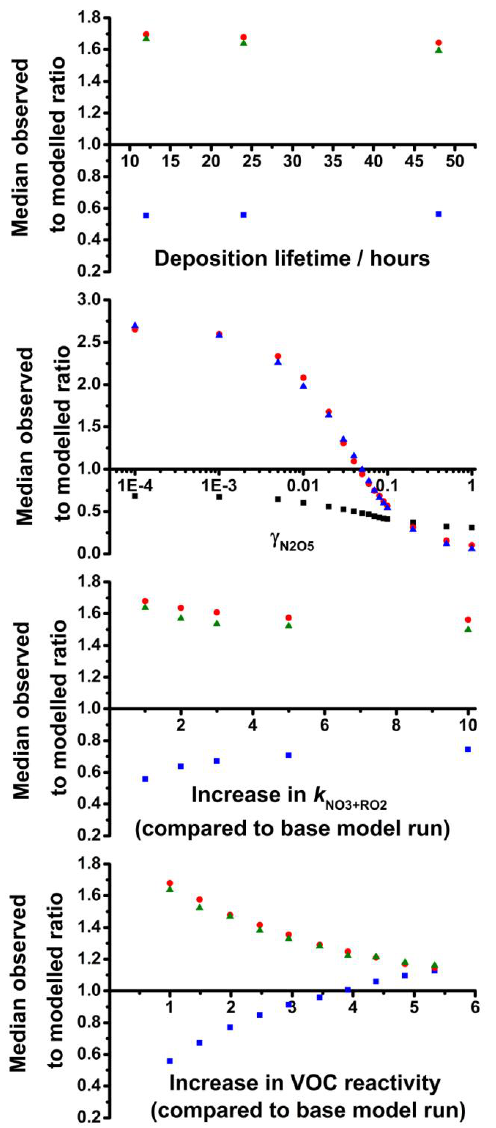
Fig. 12. Sensitivity of median modelled to observed ratios of HO 2 * Figure 12: Sensitivity of median modelled to observed ratios of HO 2 * (blue), NO 3 (red) and N 2 O 5 (blue), NO 3 (red) and N 2 O 5 (green) towards (a) the deposition (green) towards (a) the deposition lifetime adopted in the model; (b) γ N2O5 ; (c) rate coefficients for NO 3 lifetime adopted in the model, (b) γ N , (c) rate coefficients for 2 O 5 + RO 2 ( k NO3+RO2 ) adopted in the model; (d) concentrations of unsaturated VOCs in the model. Changes ) adopted in the model, and (d) concen- NO 3 + RO 2 ( k NO 3 + RO 2 to k NO3+RO2 and unsaturated VOC concentrations are represented as the factor by which k NO3+RO2 and trations of unsaturated VOCs in the model. Changes to k NO 3 + RO 2 and unsaturated VOC concentrations are represented as the factor total unsaturated VOC concentration have been increased compared to the base run. by which k NO and total unsaturated VOC concentration have 3 + RO 2 been increased compared to the base run.